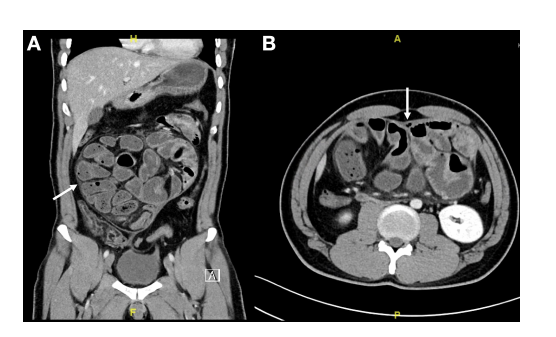
by a thick enchanting membrane forming a sac the small bowel loops are arranged radially (Arrow indicates the sac).